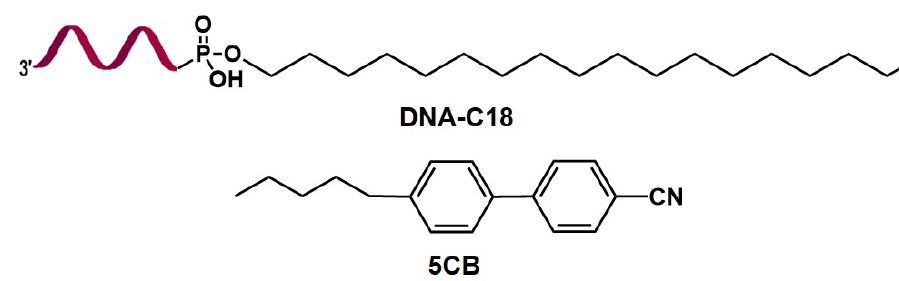
Figure 1. Structures of DNA ‐ C18 and 5CB.